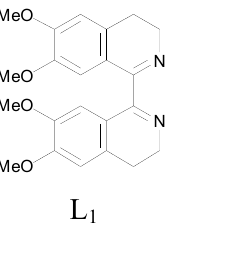
Figure 2. Structures of ligand L